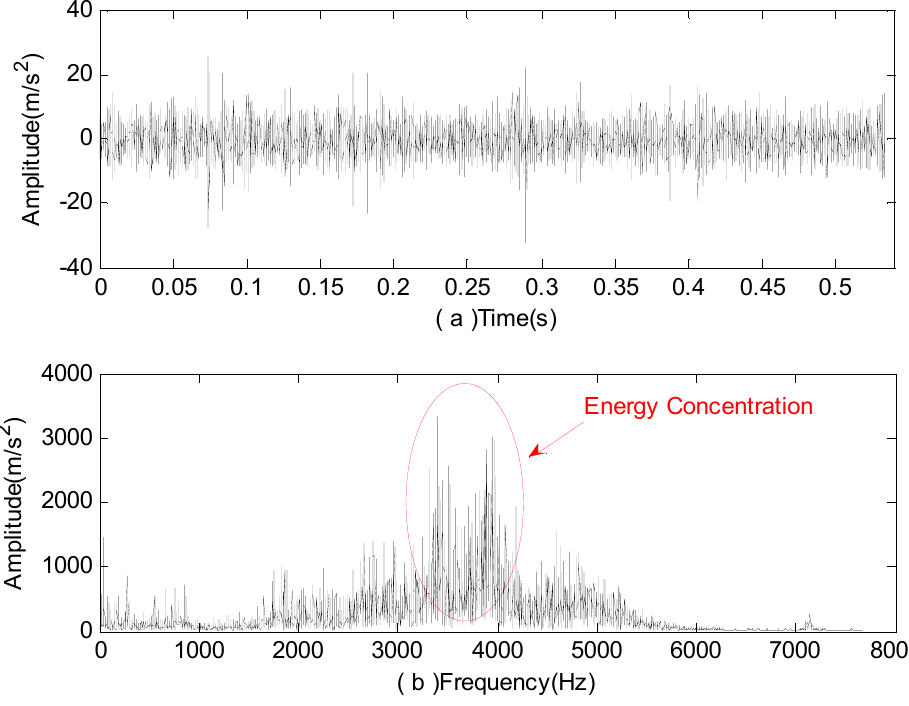
Figure 5. Analysis of signals of vibration acceleration in the case of rolling element